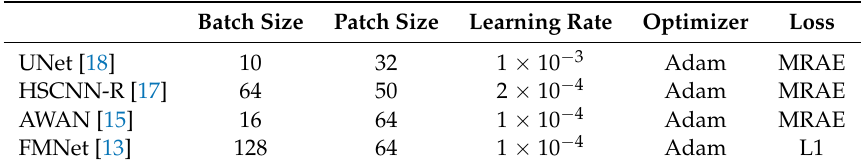
Table 1. Utilized hyperparameters for training the different